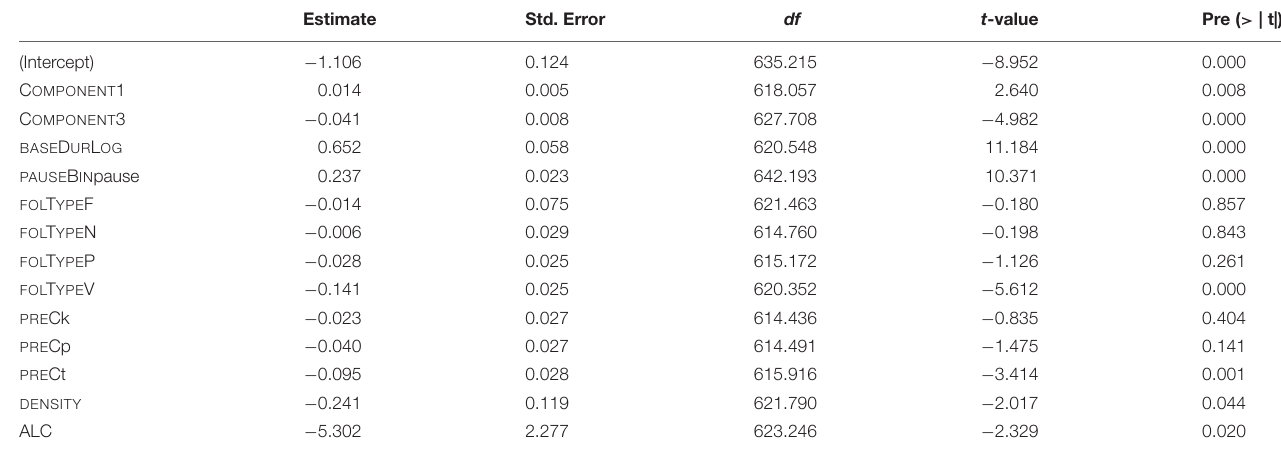
TABLE 7 | Fixed-effect coefficients and p -values as computed by the final “LDL measures and Affix” model (mixed-effects model fitted to the log-transformed duration of S). Estimate Std.